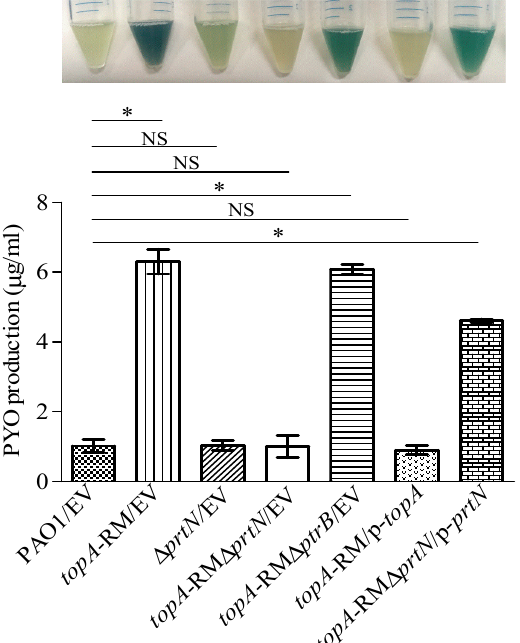
Figure 10. Comparison of the pyocyanin production in the wild-type PAO1 and mutant strains. Pyocyanin production was extracted from PB culture supernatants by chloroform and quantified using the optical density method (OD 520 ) as described in materials and methods. EV: Empty vector in the strain. p- topA and p- prtN represent intact topA and prtN carried on pUCP26, respectively. The two-tailed unpaired t -test was used to analyze the data using GraphPad software version 5.0 (*, P < 0.05). NS: No significant difference. The means of values of three independent experiments are shown and the error bars indicate the standard deviations.